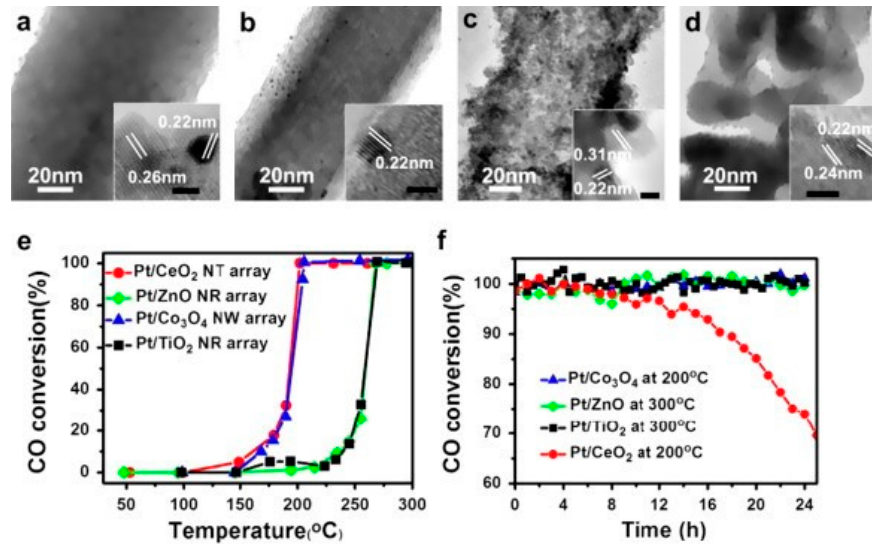
Figure 4. CO oxidation over Pt ‐ loaded metal oxide nano ‐ array ‐ based monolithic